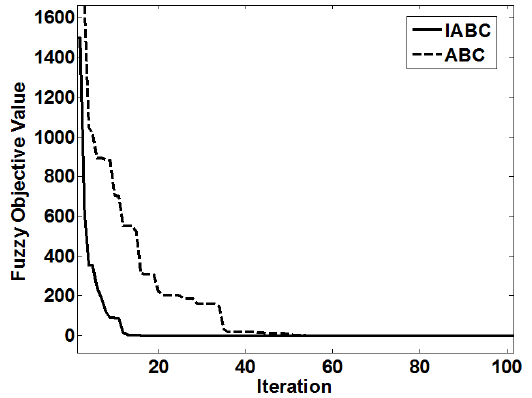
Figure 16. Convergence characteristics of the IABC and ABC algorithms for multi-objective OPF for the IEEE 57-bus